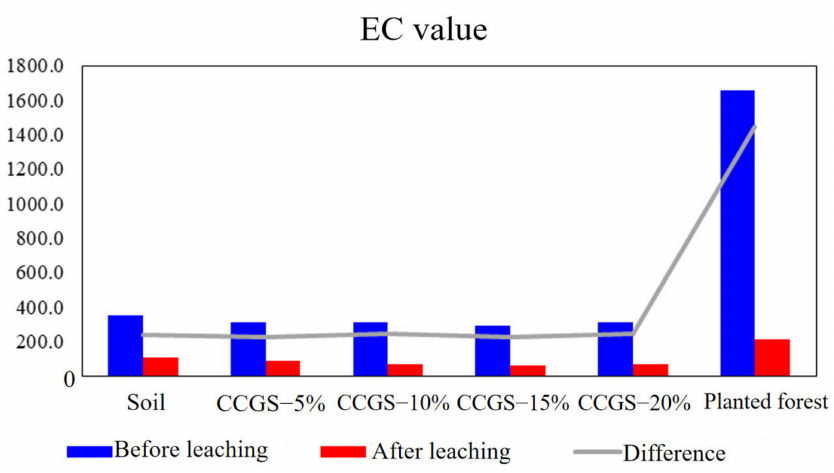
Figure 13. Effects of CCGS on soil